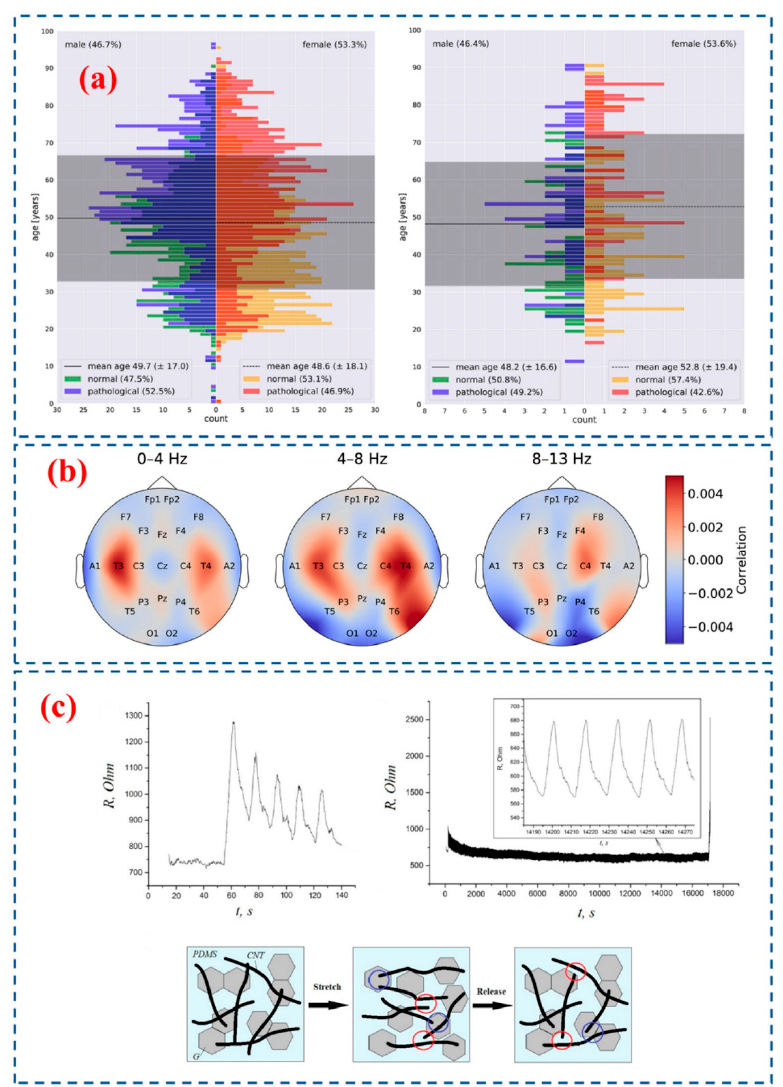
Figure 7. ( a ) The construction of the EEG histogram and the age pyramid with sections for male and female patients using ML (adapted with permission from [197] Elsevier, 2020) ( b ) The temporal electrode sites T3 and T4 exhibiting a pathological class with increase in amplitudes measured by neural networks (adapted with permission from [197] Elsevier, 2020) ( c ) Mechanism of conductivity of the hybrid PDMS/CNT biocompatible composites and their resistance vs. time plots (adapted with permission from [198], MDPI, 2021)